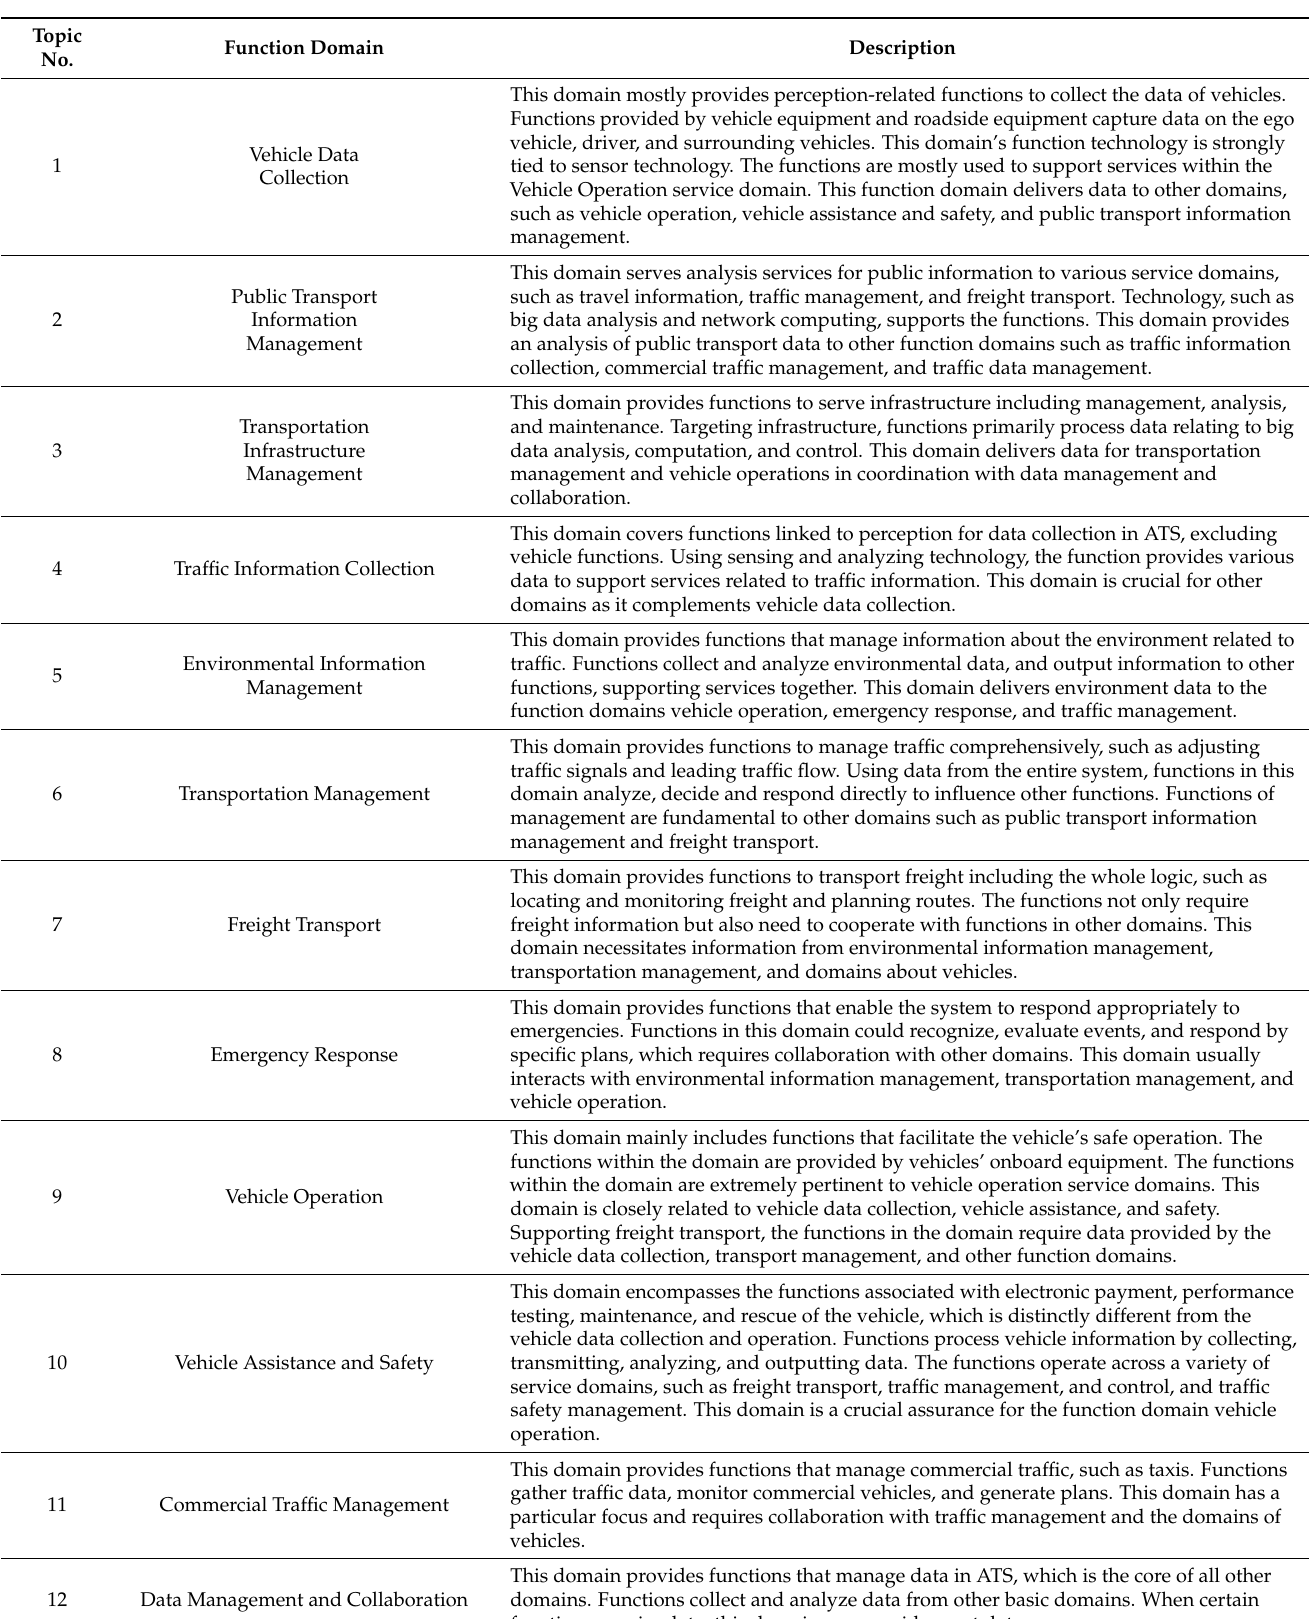
Table 3. Description of function